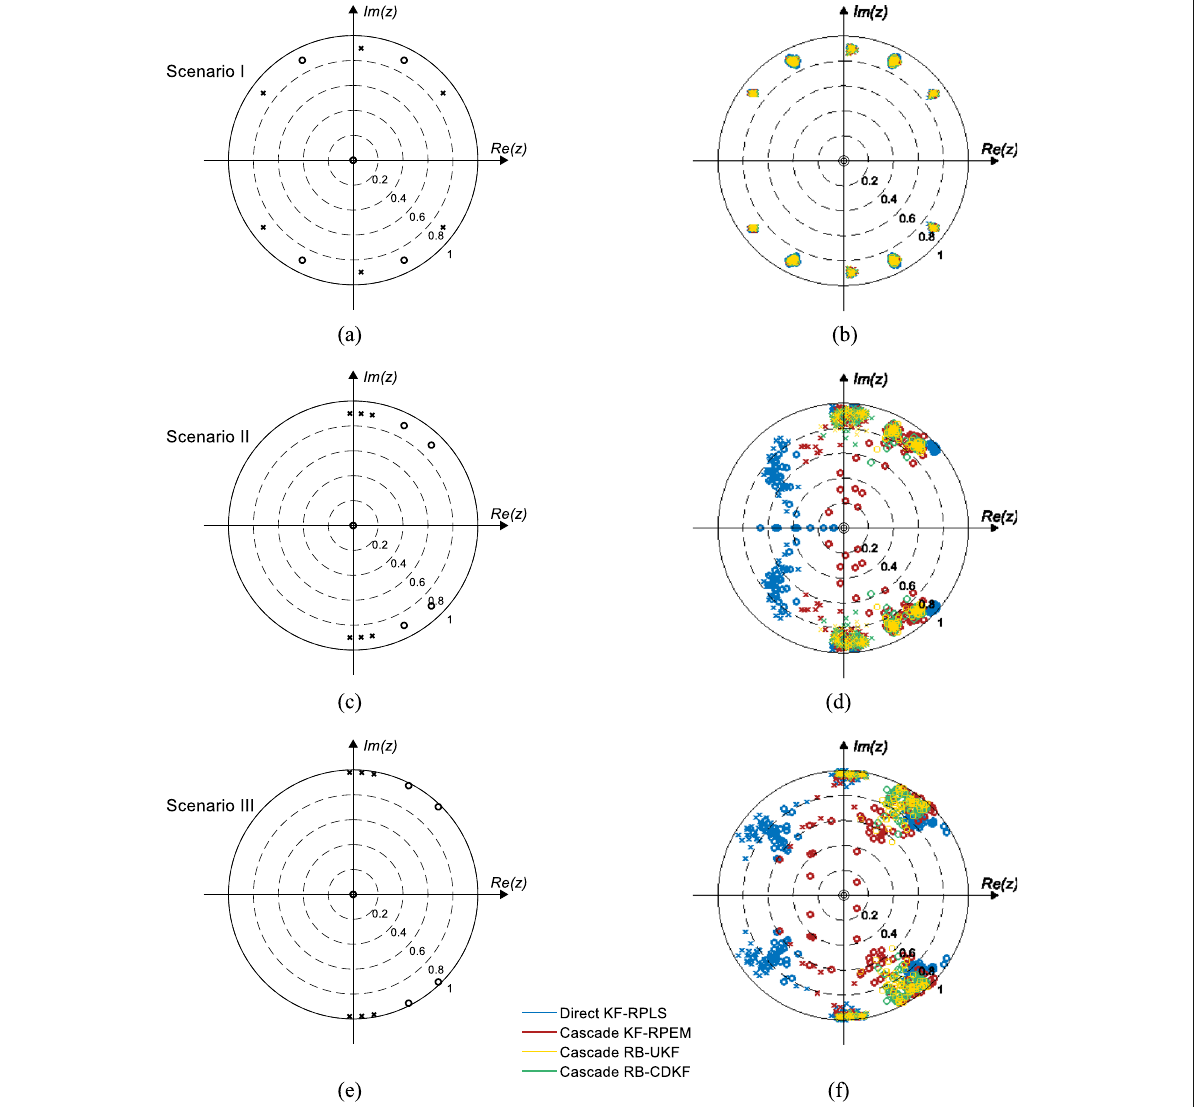
Fig. 4 Pole-zero plots of the actual simulated (left panel a , c , e ) and estimated ARMA processes (right panel) for Scenarios I (upper panel), II (middle panel), and III (bottom panel). Blue, red, yellow, and green markers refer to direct-form models estimated by KF-RPLS and cascade-form models estimated by KF-RPEM, RB-UKF, and RB-CDKF,